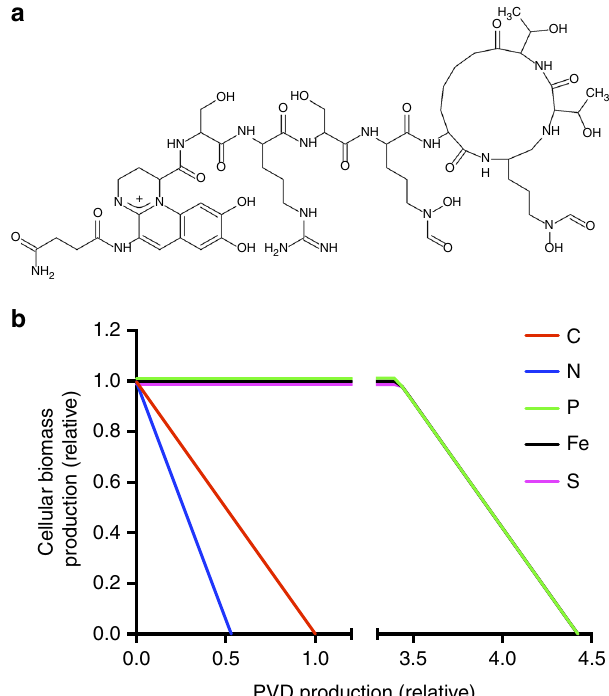
Fig. 1 Relationship between PVD structure and metabolic cost of secretion. a Illustration of the PVD structure ( P. aeruginosa PAO1 Type I), which is comprised primarily of C and N. b Metabolic model. Flux-balance analysis was performed to analyze the trade-off between the levels of cellular biomass production and PVD production. Different nutrient-limiting conditions were achieved by restricting the respective nutrient uptake rates.